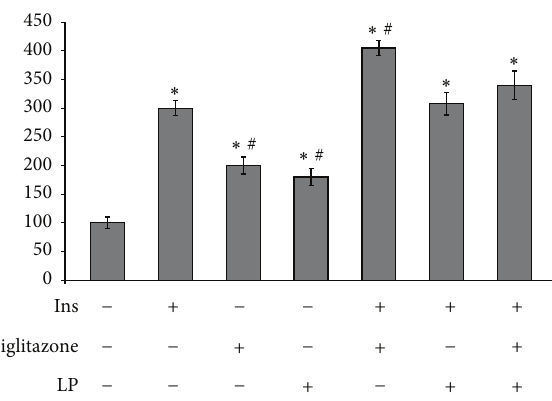
Figure 3: Effects of LP on glucose uptake. Glucose uptake activity in 3T3-L1 adipocytes under insulin-resistant condition in the presence and absence of insulin. The glucose uptake value of untreated cells was set 100, and the others were relative values. Data represented the mean ± SEM ( 𝑛 = 5 ). ∗ 𝑃 < 0.05 versus control, # 𝑃 < 0.05 versus insulin